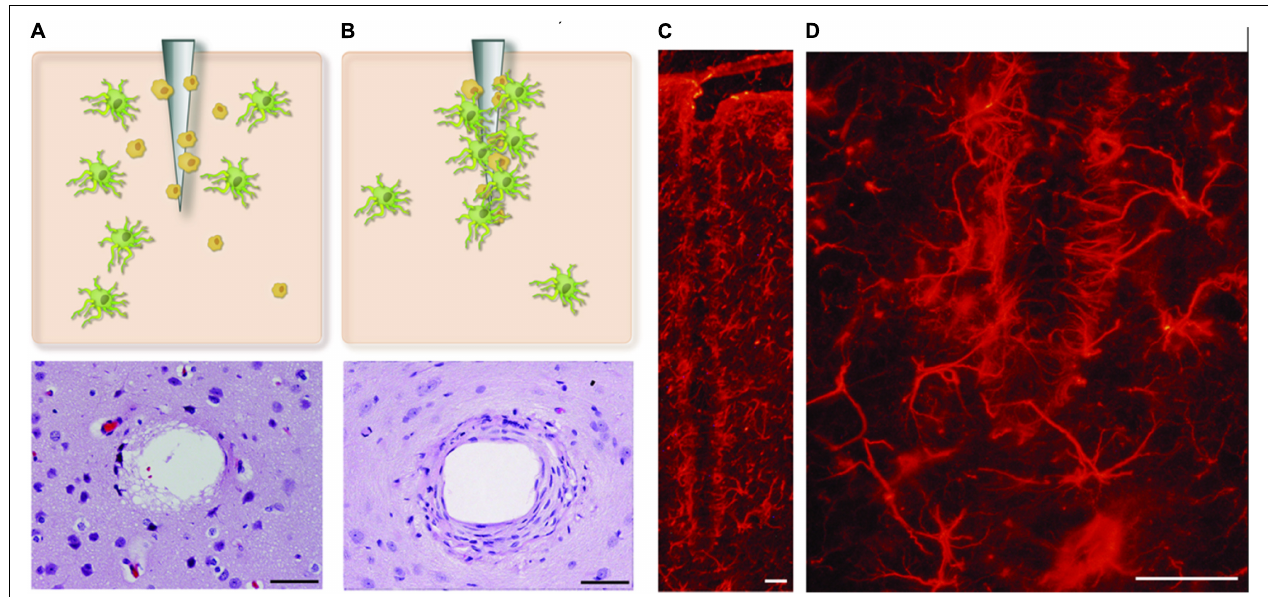
FIGURE 1 | Glial encapsulation of intracortical microelectrode. (A,B) Shows two stages of glial activation where astrocytes and microglial cells are activated and incapsulate probe at the site of injury. (C,D) The reactive astrocytes, immunohistochemically labeled here for GFAP, encapsulate the neural probes forming a dense cellular sheath. Figure adapted from Marin and Fernandez (2010). Scale bar = 50 µ m.